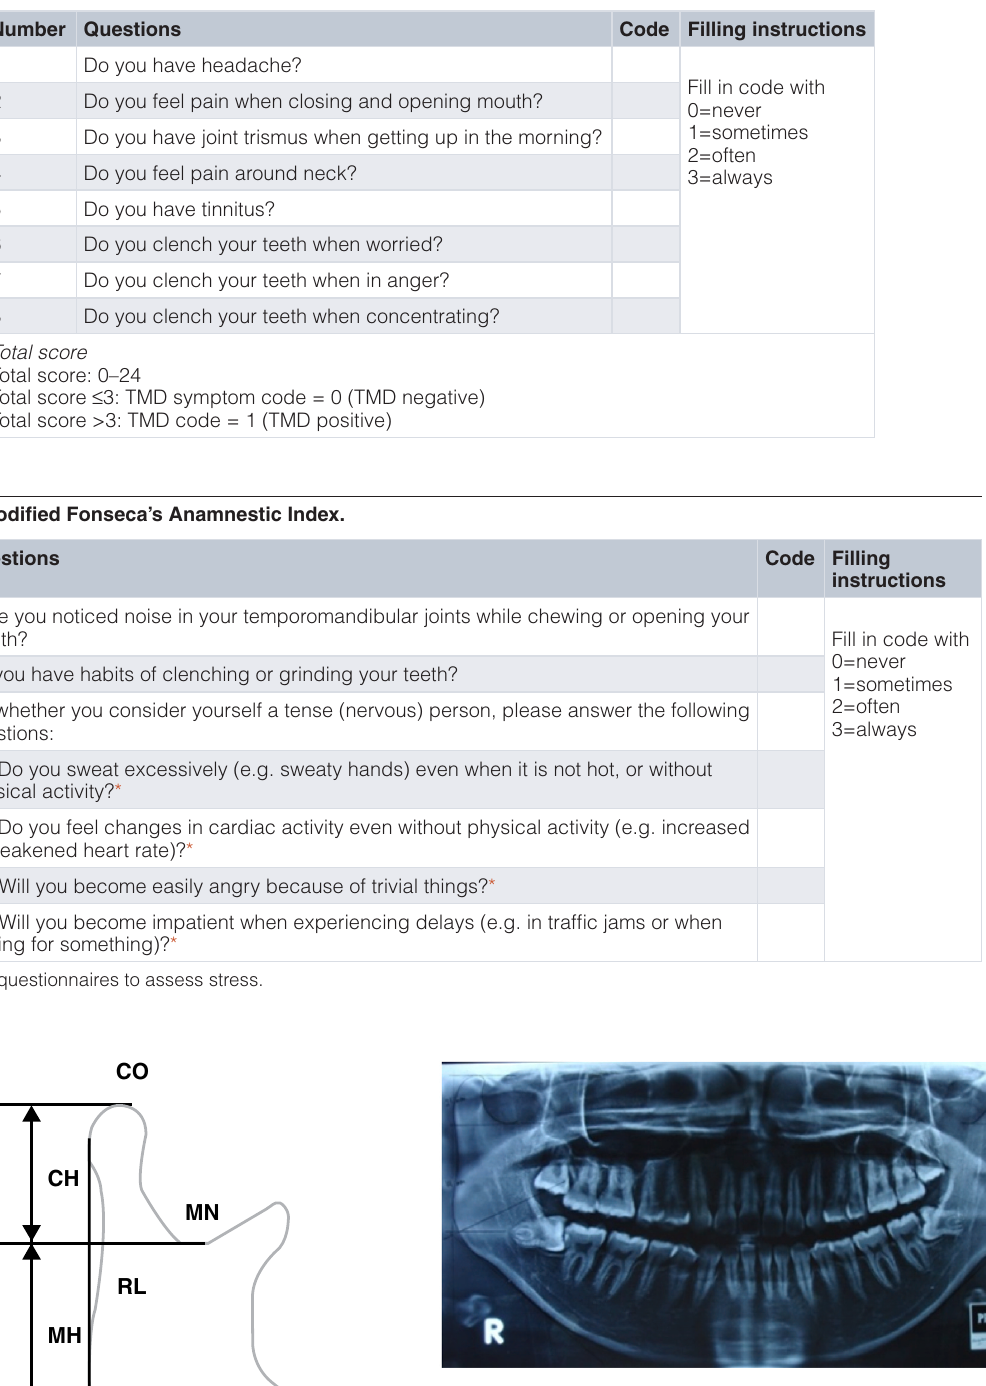
Figure 2. The measurement of panoramic radiograph that used in this study.